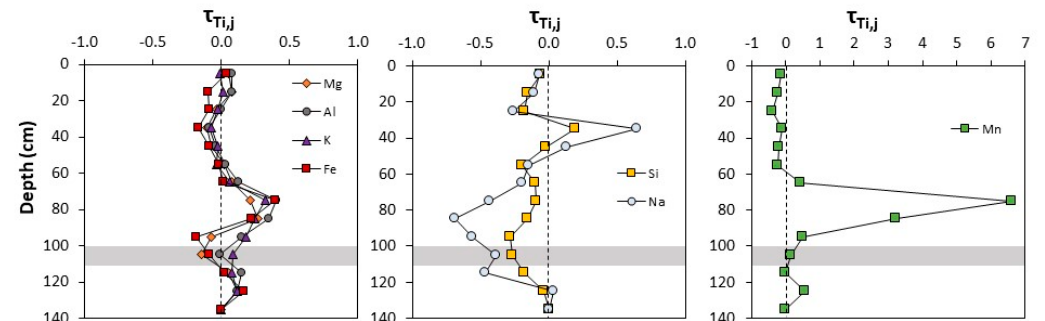
Figure 4. Mass transfer coefficient τ Ti,j versus depth for mobile elements (subscript j ) in the bulk soil. Elements in each panel are grouped by similar patterns. τ Ti,j <0 indicates element loss relative to the parent material with τ Ti,j = –1 denoting complete depletion. τ Ti,j >0 indicates an element addition relative to the parent material. Here, the deepest soil sample was chosen to represent the parent. The depth of the organic-rich soil layer is shown by the horizontal grey bar. Table 2. Soil mass transfer coefficient, τ Ti,j (Equation (5)), for the HR25-BY1 soil core. Depth (cm) τ Ti,Na τ Ti,Mg τ